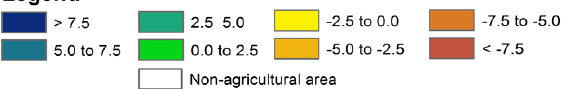
Figure 6 Mean SVI values from 1982-1992, 1993-2002, and 2003-2015